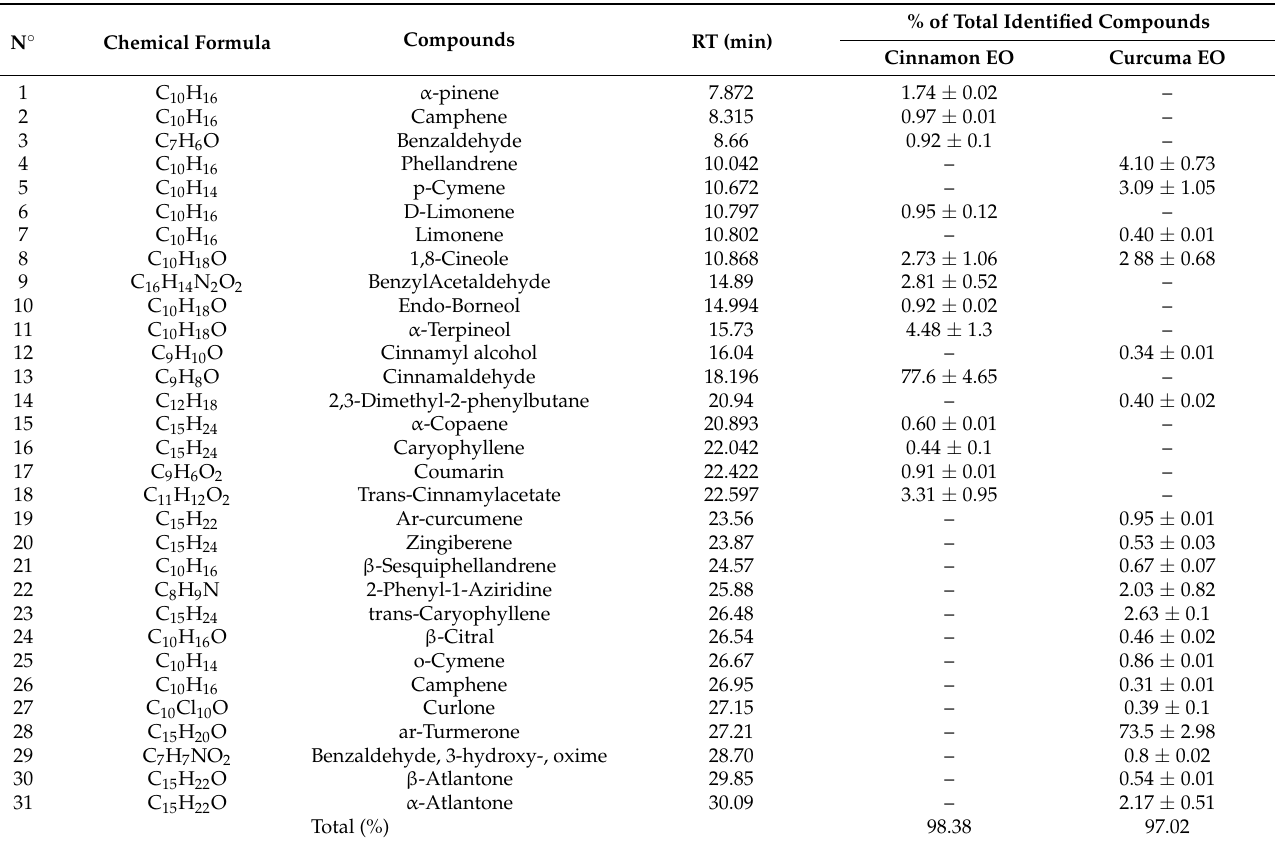
Table 2. Chemical composition of cinnamon and curcuma EOs (expressed as the % of total identified compounds) RT: retention time (in